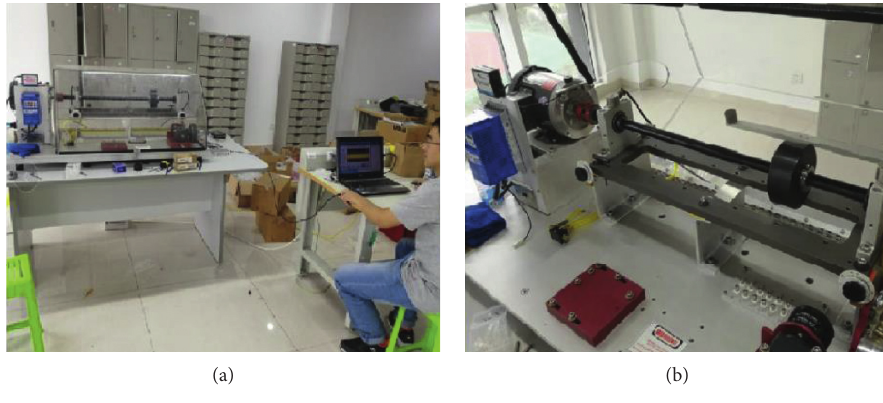
Figure 20: Experimental test rig 2.